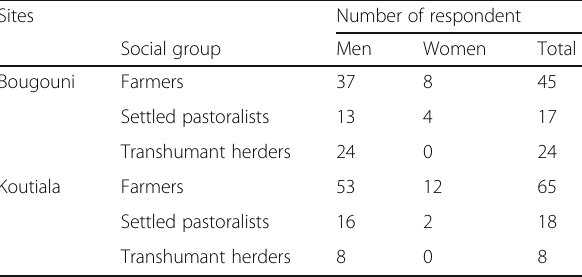
Table 1 Category of respondents involved in individual interview